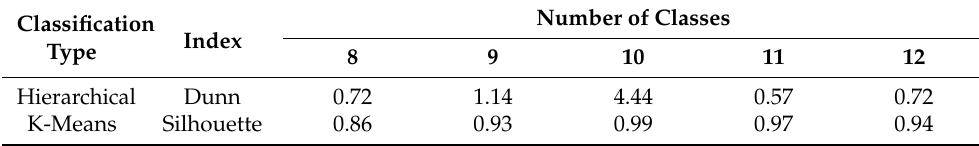
Table 2. Dunn and Silhouette indexes for various numbers of